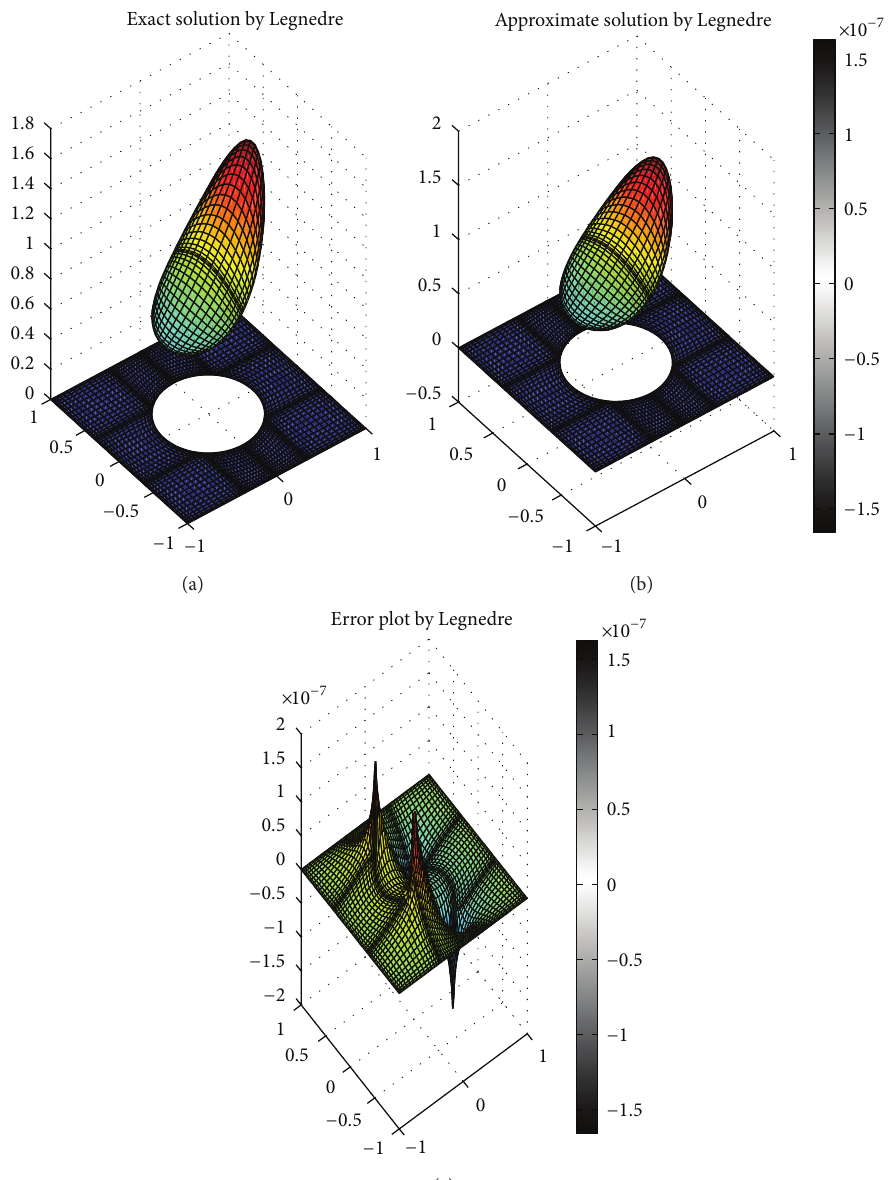
Figure 7: Exact solution, approximation solution, and its error for 𝑁 = 18